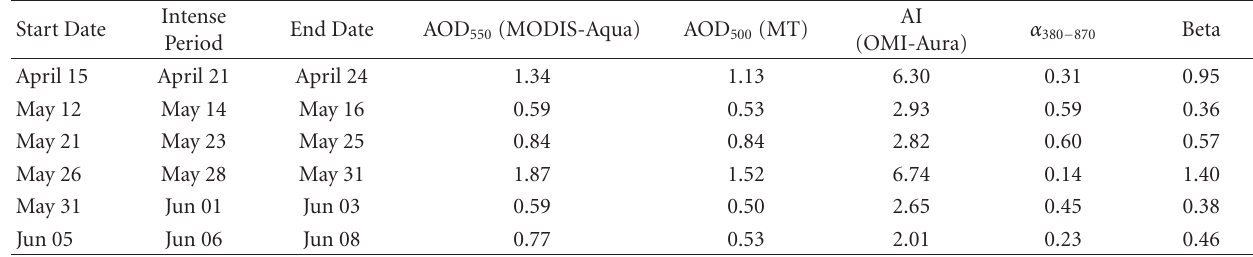
Table 1: Values of Aqua-MODIS AOD 550 , MICROTOPS-II AOD 500 , Aura-OMI AI, and ˚Angstr¨om parameters for six days with DE over Patiala, northwestern India during premonsoon season of 2010.